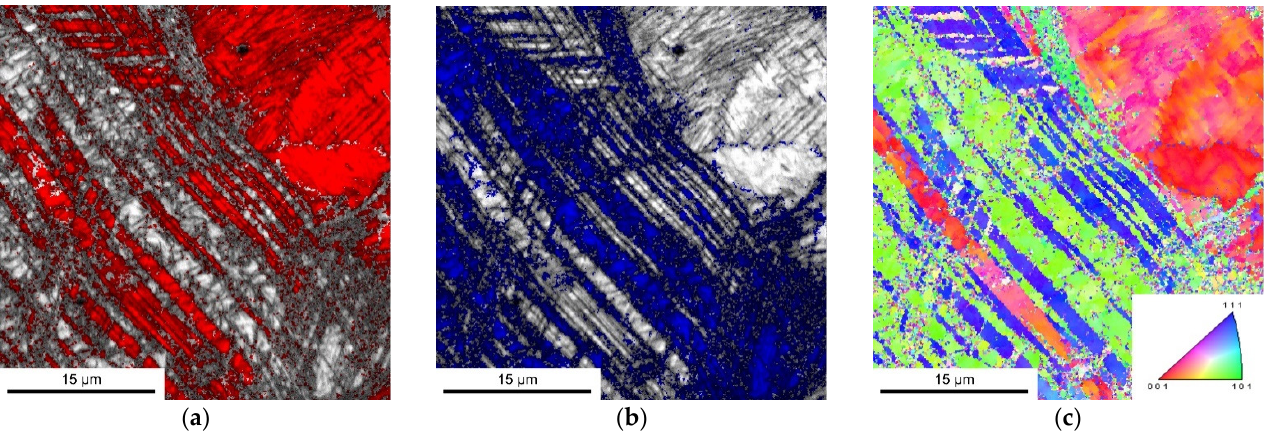
Figure 5. Microstructure of the 0.2C steel in the gauge section after tensile test at RT: ( a ) IQ + EBSD phase map of austenite (red), ( b ) IQ + EBSD phase map of strain-induced α ´-martensite (blue), and ( c ) IPF map of austenite and α ´-martensite. The tensile direction is normal to the plane of view.